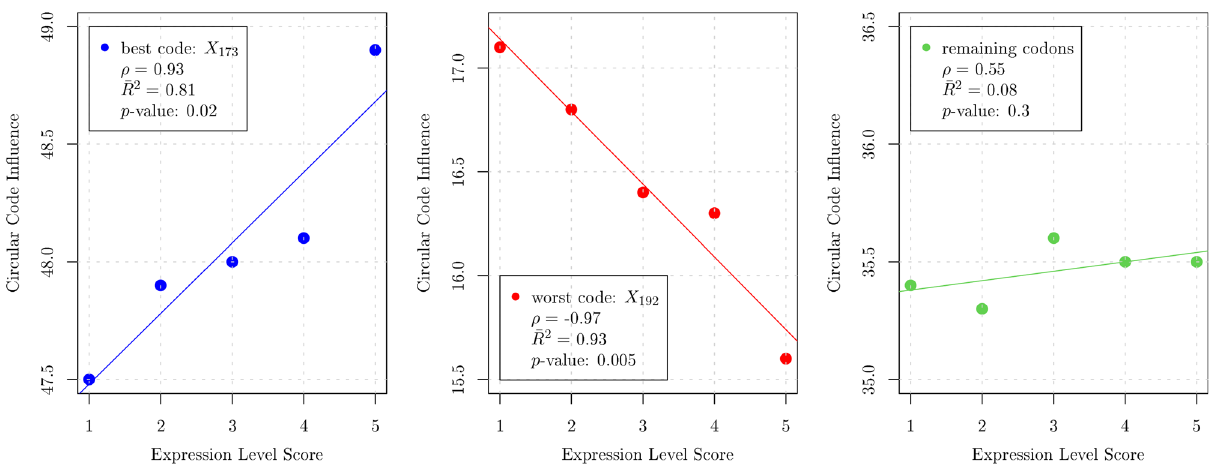
Figure 7. Expression level score versus average cumulative influence of circular codes. Left panel: best code X X 173 . Center panel: worst code 192 . Right panel: remaining codons, excluding